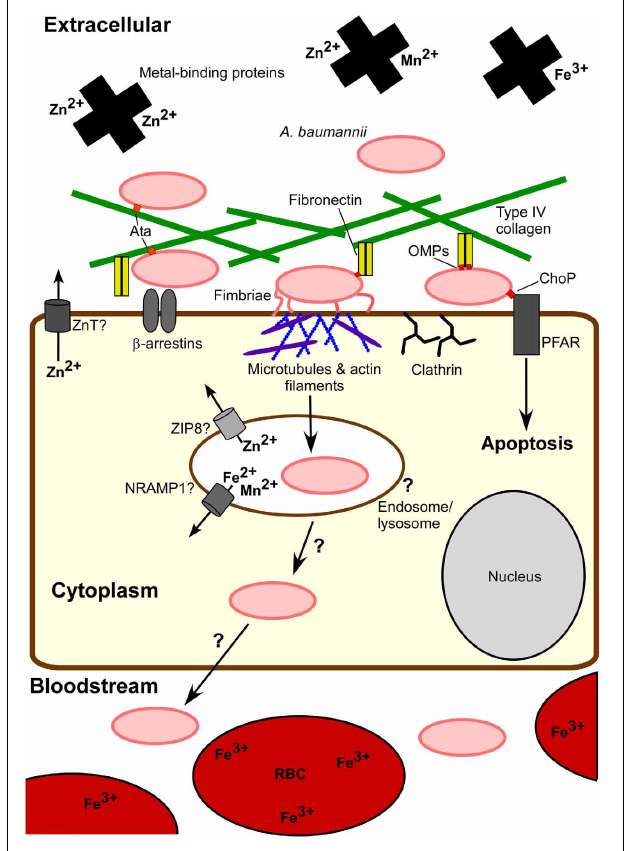
FIGURE 2 | A. baumannii- host cell interactions. Extracellular A. baumannii experiences a metal-limited environment at least in part due to metal-binding host proteins and intracellular localization of metals, e.g., red blood cells (RBCs). A. baumannii attaches to host cells through interactions between fibronectin and bacterial outer membrane proteins (OMPs), such as OmpA, as well as Type IV collagen via Ata. These OMPs may bind to other host cell proteins, for example the interaction of OMP ChoP with platelet activating factor receptor (PFAR). Fimbriae also contribute to eukaryotic cell adherence. Invasion into epithelial cells occurs via host cell actin filament and microtubule reorganization, recruitment of β -arrestin and clathrin, and a bacterial uptake via a zipper-like mechanism. Although A. baumannii can persist intracellularly and includes entry into endosomes, the intracellular trafficking of A. baumannii is not clear. Eukaryotic cell proteins NRAMP1, ZIP8, ZnTs, and other transporters pump essential metals out of endocytic vesicles and the cytoplasm, limiting the intracellular pool available to pathogens. The physiological relevance of the intracellular lifecycle of A. baumannii remains to be understood. One consequence of host cell exposure to A. baumannii is apoptosis. It is possible that cell death and/or host cell invasion serve to permit A. baumannii dissemination to deeper tissues leading to invasive